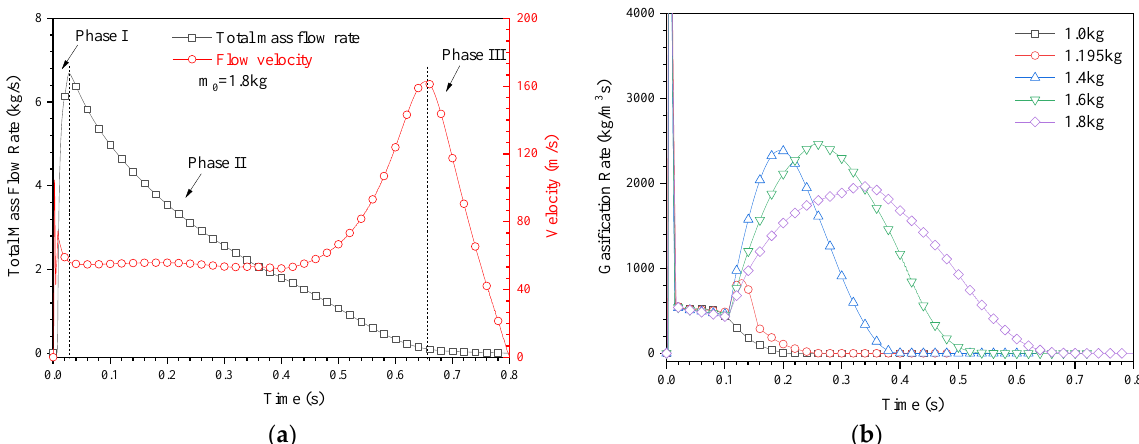
Figure 16. Diagram of flow velocity and gasification rate: ( a ) comparison of flow velocity and total mass flow rate; ( b ) variation of gasification rate under different filling amounts.